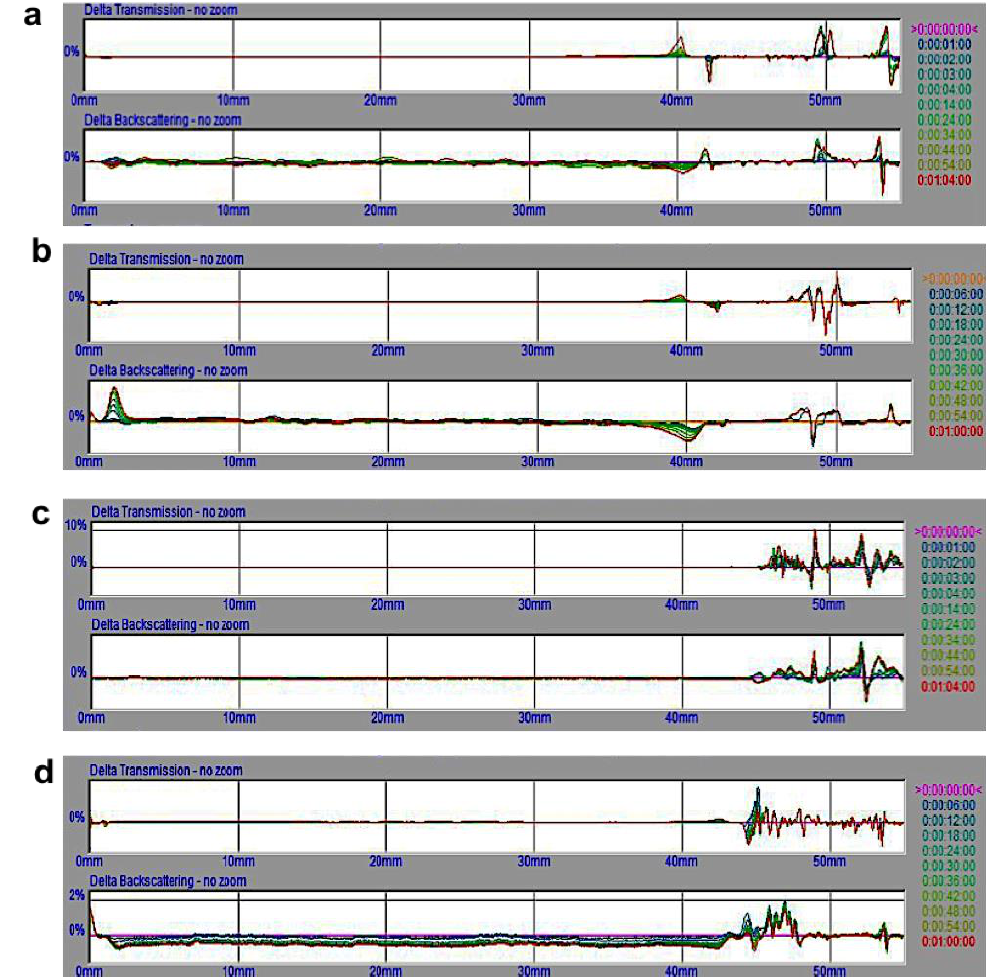
Figure 10. Presentation of the destabilization kinetics of ( a ) day 1 of CLF-SLN, ( b ) day 120 of CLF-SLN, ( c ) day 1 of CLPF-SLN and ( d ) day 120 of CLPF-SLN suspension, indicating ∆ BS and T calculated at 25 ± 0.5 °C for 60 min duration.